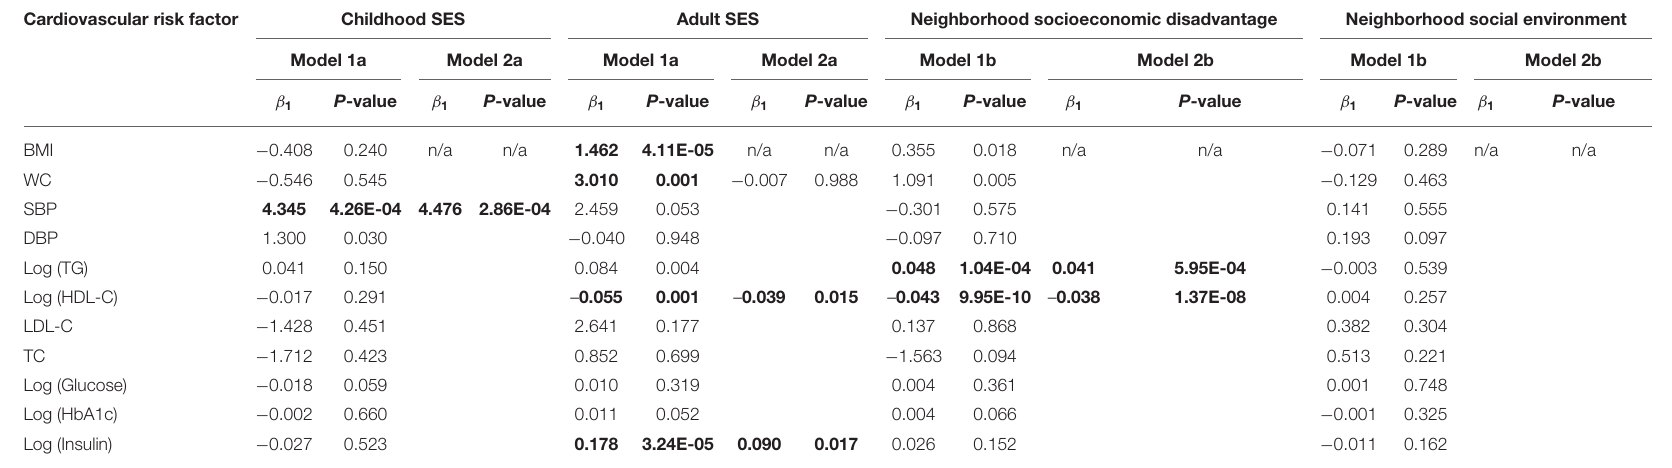
TABLE 2 | Associations between individual SES/neighborhood characteristics and cardiovascular risk factors ( N =